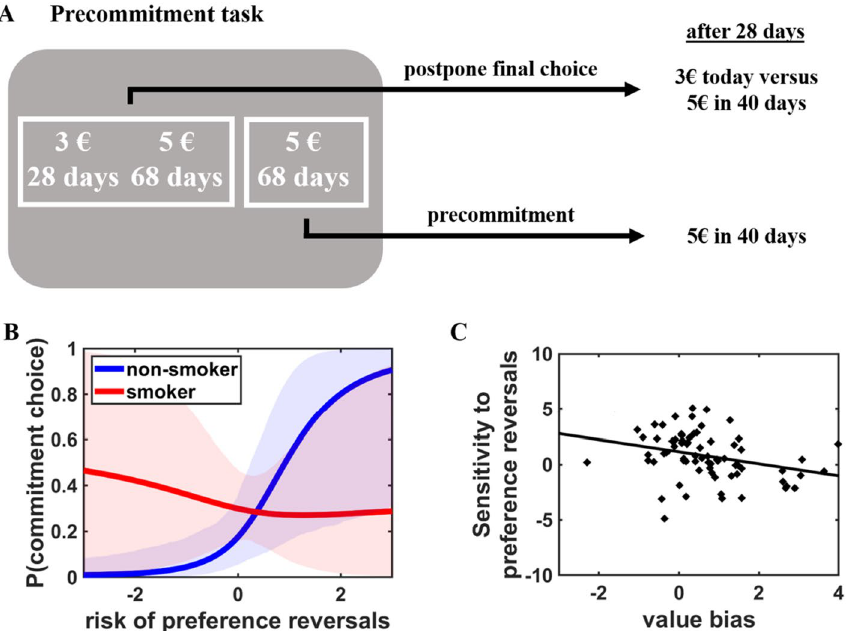
Figure 3. ( A ) In the precommitment task, participants opted between making a binding choice for a larger- later reward (e.g., 5 euro in 68 days) or postponing the decision. In the latter case, participants were re-contacted after 28 days and had to make a final choice between the adjusted reward options (in this example, “3 euro today versus 5 euro in 40 days”). ( B ) While non-smokers more strongly preferred to make a binding choice with increasing risk of preference reversals (i.e., the preference switches from the larger-later to the smaller-sooner option when being re-contacted after 28 days), smokers’ precommitment choices were unaffected by potential preference reversals. ( C ) The sensitivity to preference reversals correlated with individual differences in value bias, i.e. the degree to which individuals overestimate their preference for delayed over immediate rewards. Shaded areas in ( B ) indicate 95% confidence